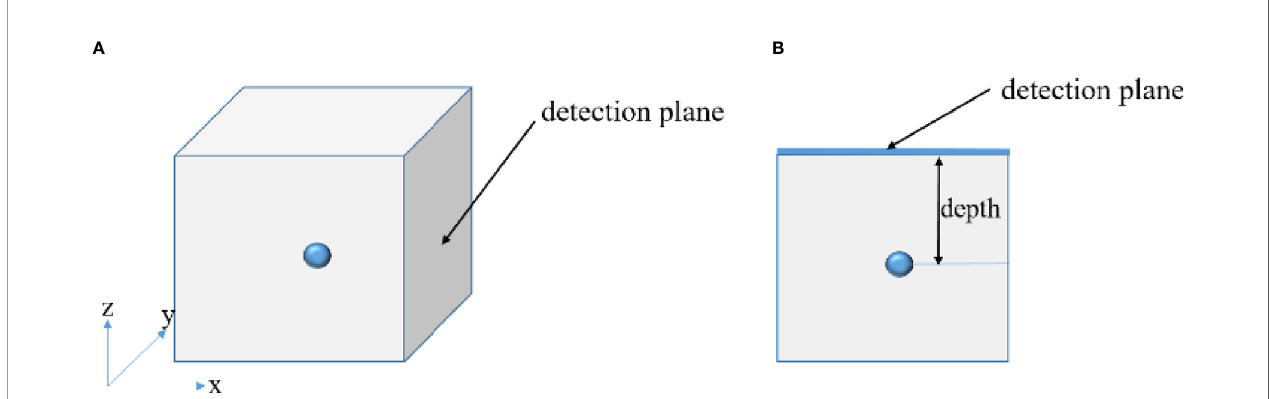
FIGURE 1 | Schematic diagrams of the simulation model indicating where the single-view image was collected (A) and of the de fi nition of the depth